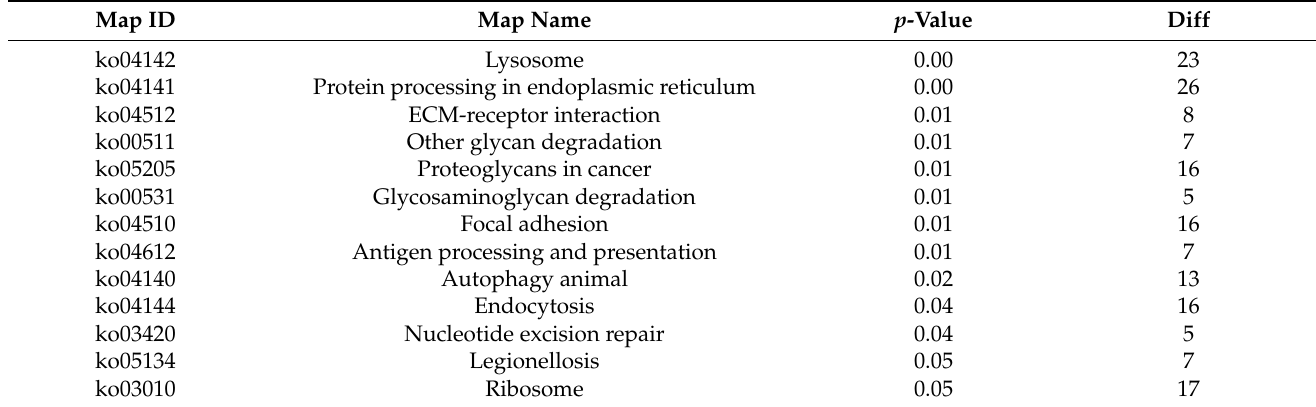
Table 4. Significant enrichment of KEGG pathways ( p < 0.05) in the Chinese mitten crab infected with P. gregaria .